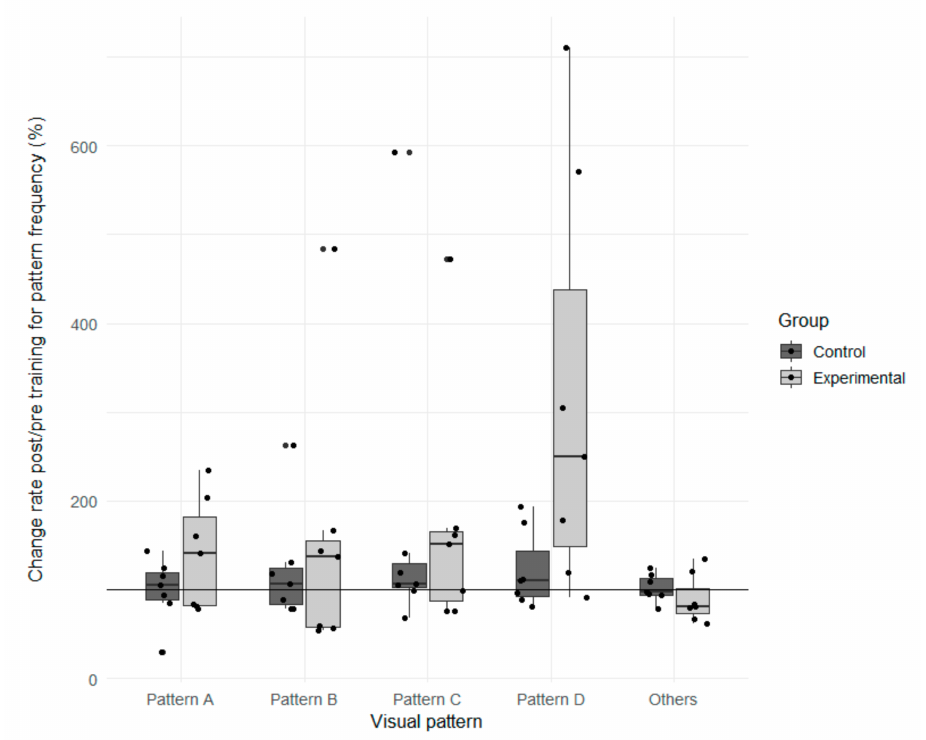
Figure 14. Evolution of the four efficient visual scanning patterns ( A – D ) and the other visual scanning patterns for the control and the experimental groups between pre- and post-training